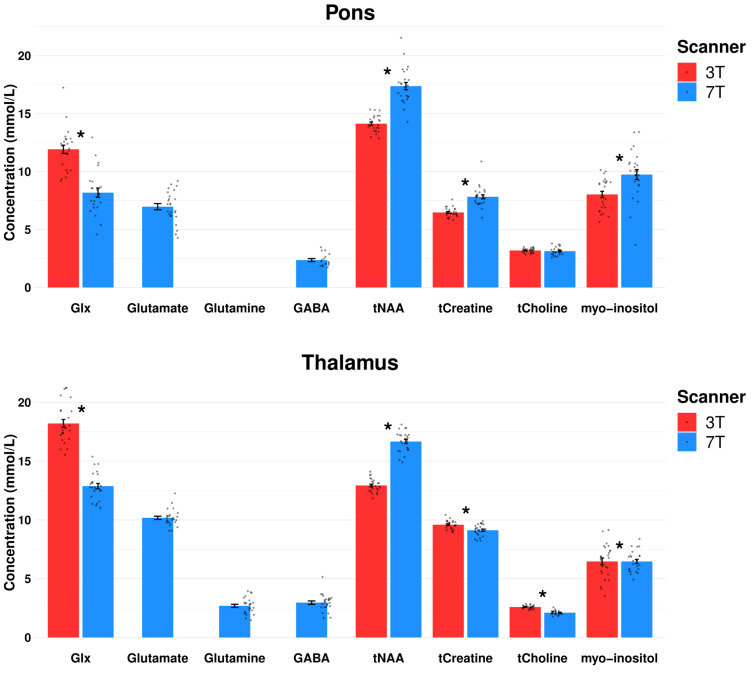
Comparison of mean metabolite concentration estimates for pons and thalamus at 3T vs. 7T of placebo day and baseline measurements. Dots represent each spectral measurement. *p < 0.05. Error bars denotes standard error of the mean, Glx, glutamate + glutamine; GABA, γ-aminobutyric acid; tNAA, N-acetylaspartate + N-acetylaspartyl glutamate; tCreatine, creatine + phophocreatine; tCholine, glycerophosphocholine + phosphocholine.